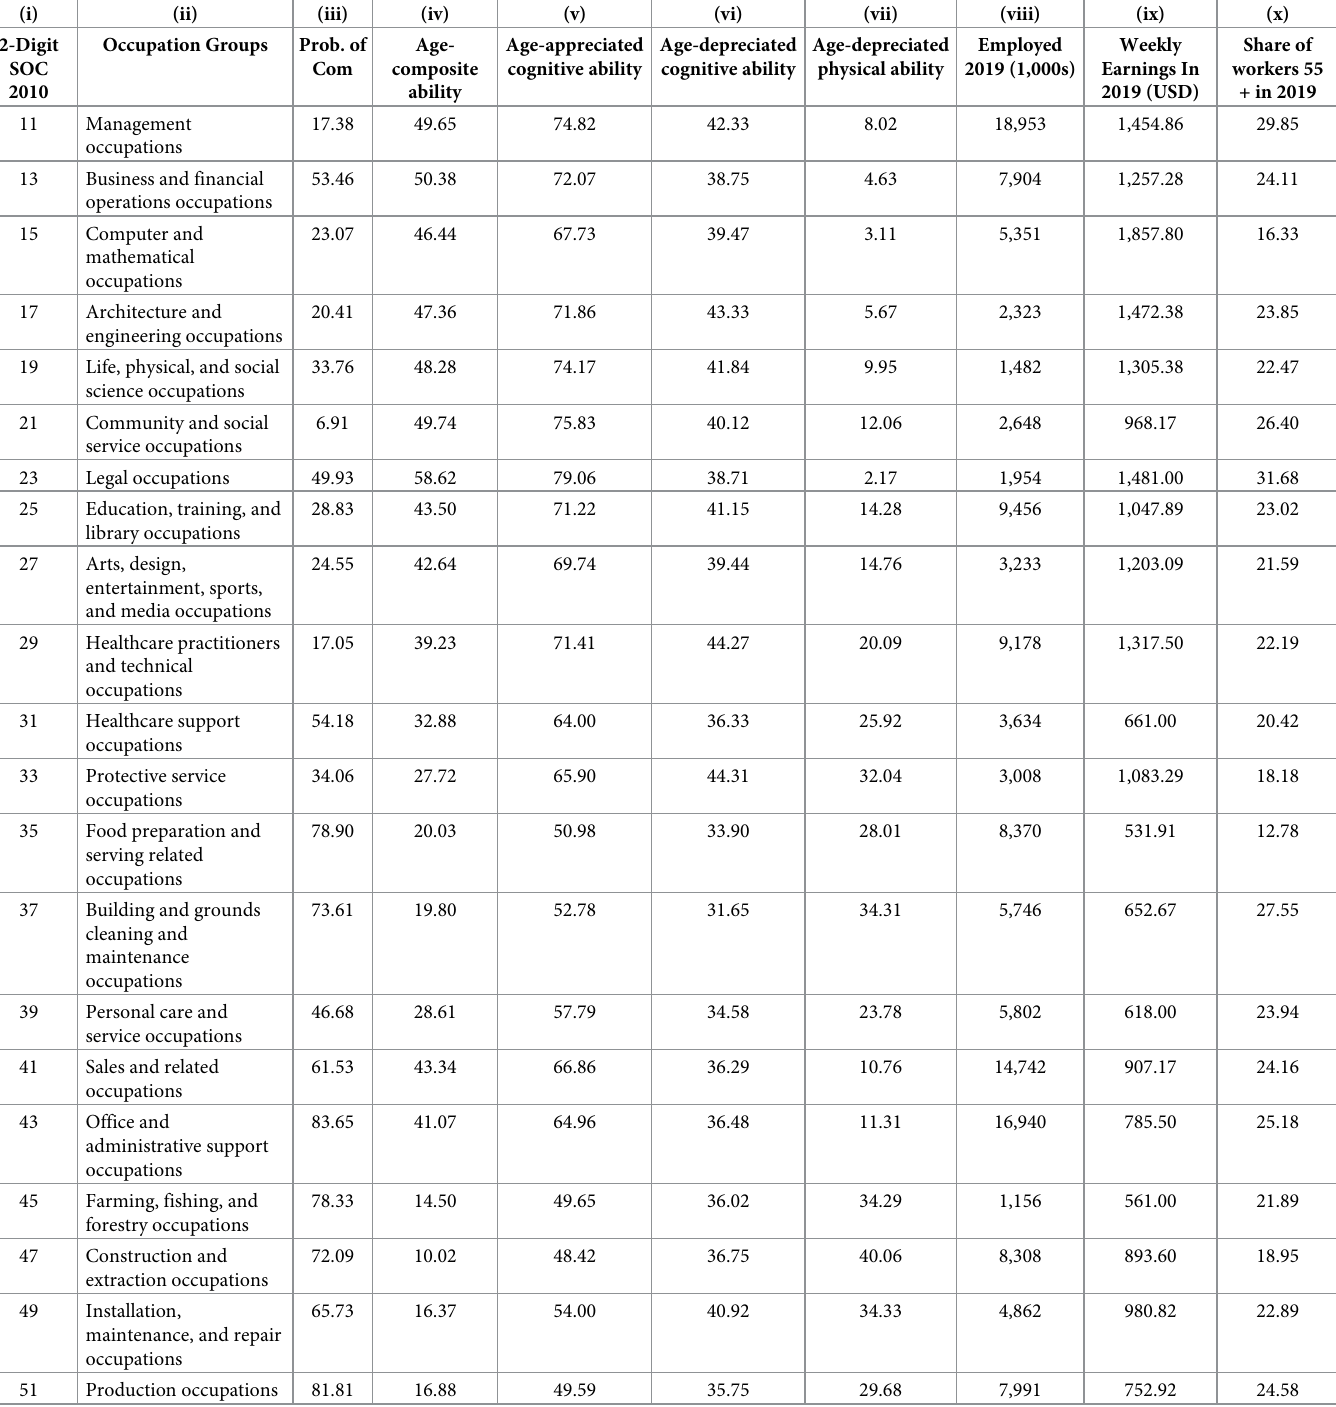
Table 2. Summary statistics for the 2-Digit SOC2010 occupation